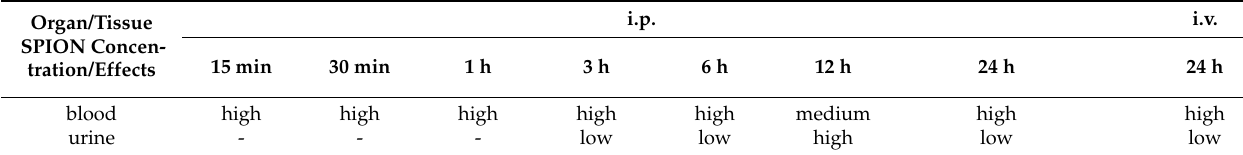
Table 1. Summary of SPION-PEG cluster distribution and effects observed in our